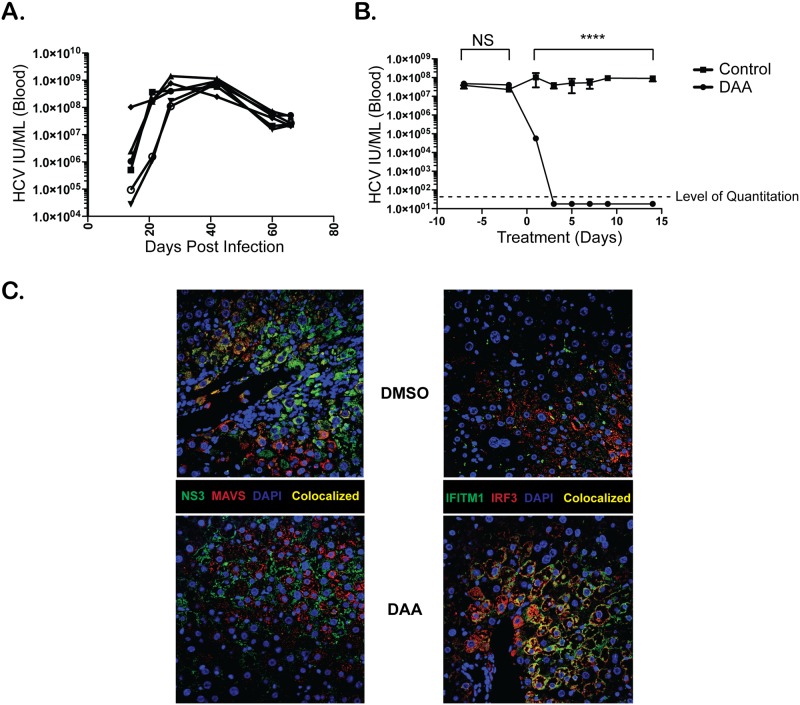
Restoration of HCV-suppressed antiviral signaling in the liver of humanized mice treated with DAAs.(A) Serum levels of HCV in mice injected with 1.4 x 106 IU HCV intravenously. (B) HCV viral loads after treatment with Sofosbuvir (2.0mg daily), Daclatasvir (0.3mg daily), Asunaprevir (0.5mg twice daily) or DMSO vehicle control via oral gavage. (C) Protein expression of NS3, MAVS, IFITM1, and IRF3 following 14 days of DMSO treatment or DAA treatment in whole liver tissue via immunofluorescence staining. N = 3 mice per group. ****P<0.0001, NS = Not significant.